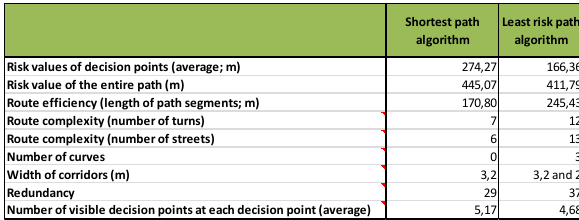
Figure 6: Comparison of the parameters between an example shortest and least risk